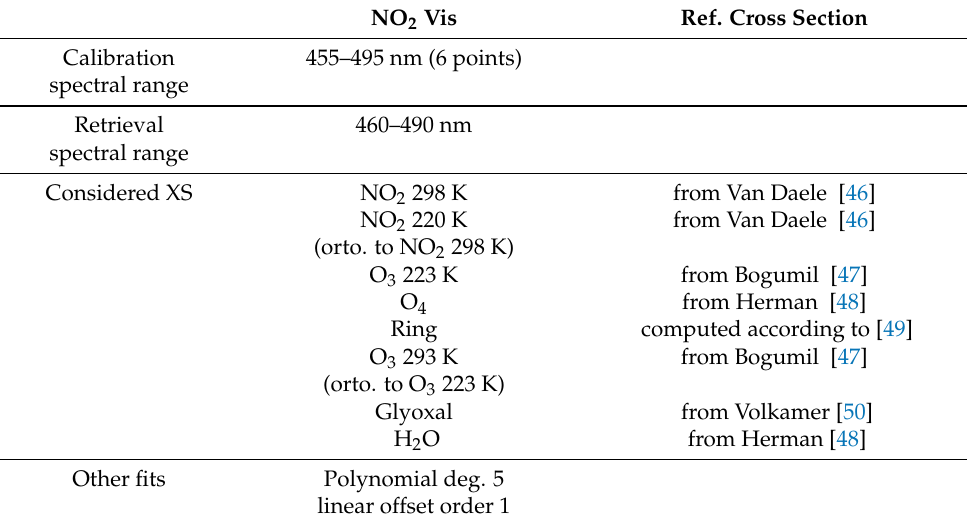
Table A1. QDOAS settings for TROPOGAS NO 2 SCDs calculations in visible spectral range; “orto.” means that cross sections are orthogonalized with respect to another cross section at a different temperature.